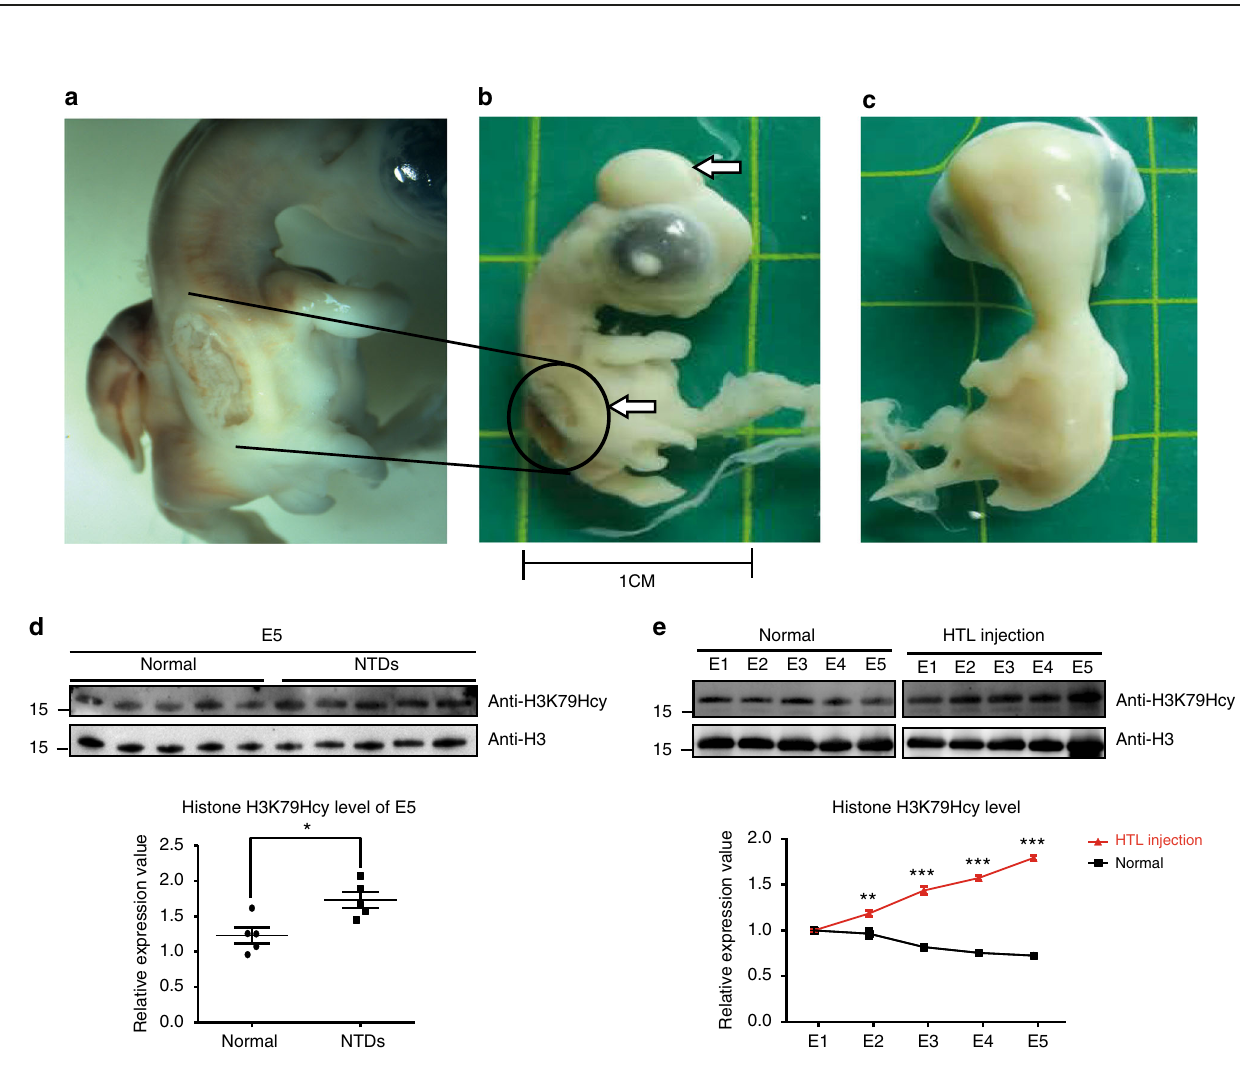
Fig. 5 Increase of histone H3K79Hcy in high-HTL-induced chicken NTDs. a – c Eggs treated with 0.5 mM-HTL exhibited NTDs phenotypes at stage of embryo 8 (E8); the arrow in b (upper) showed a meningoencephalocele and the arrow in b (below) showed spinal bi fi da aperta. a is a local enlargement of spina bi fi da aperta. c is the normal phenotypes of chicken at stage of embryo 8 without HTL treatment. d Increased expression of histone H3K79Hcy in high-HTL-induced chicken NTDs. Upper panel: western blotting of H3K79Hcy modi fi cation from normal ( n = 5) and high-HTL-induced chicken NTDs ( n = 5); lower panel: quanti fi cation of the western blotting signal intensity shown in scatter plot. Normal: 1.232 ± 0.1117 ( n = 5); NTDs: 1.732 ± 0.1119 ( n = 5); * p = 0.0133, NTDs vs. normal brain tissues. The p values were calculated with unpaired t test. e Increase in histone H3K79Hcy expression during brain development in high-HTL-treated chicken and decrease in histone H3K79Hcy expression during normal chicken development. E1: 24 h after embryos incubation; E2: 48 h after embryos incubation; E3: 72 h after embryos incubation; E4: 96 h after embryos incubation; E5: 120 h after embryos incubation. Data represent mean ± SEM ( n = 3). ** p <0.01, *** p <0.001 vs. control; the p values were calculated with unpaired t during brain development, we compared levels of H3K79Hcy during normal chicken development (Fig. 5e), indicating that from E1 to E5 between normal group and HTL injection group abnormal H3K79Hcy expression may lead to the occurrence of (Fig. 5e). The results demonstrated an increase in histone NTDs in chicken. Our data suggest that elevated H3K79Hcy H3K79Hcy expression during brain development in high-HTL- modi fi cation may underlie the failure of NTC during early treated chickens and a decrease in histone H3K79Hcy expression development due to functional disturbance of Hcy metabolism.